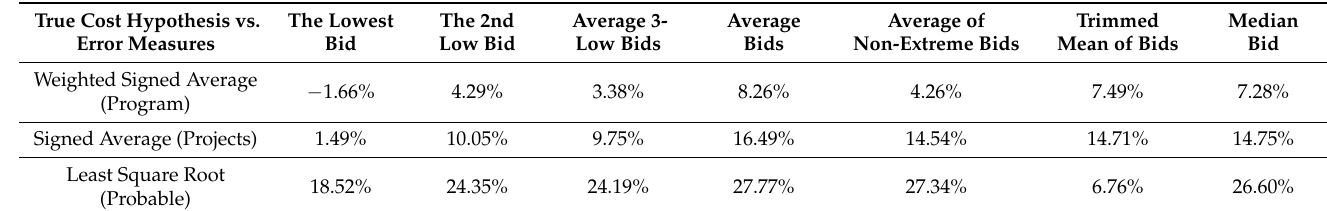
Table 1. True cost hypothesis vs. error